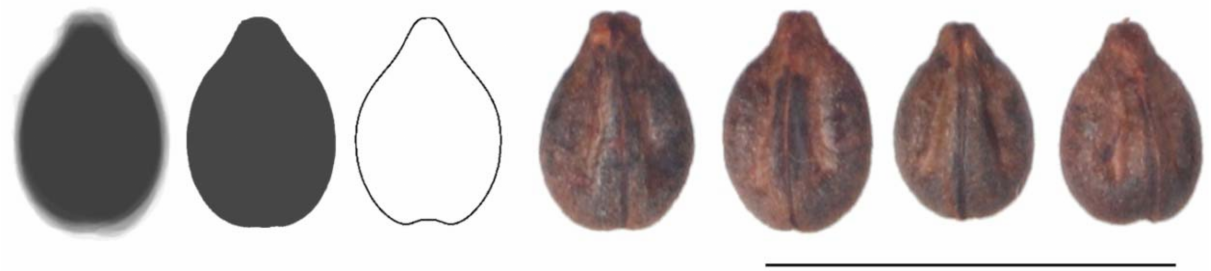
Figure 6. Sylvestris Model. From left to right: An image with the sum of the silhouettes of 30 seeds of CA 13.4, average silhouette obtained from the first image, the Sylvestris model, and four representative seeds of CA 13.4. Bar represents 1